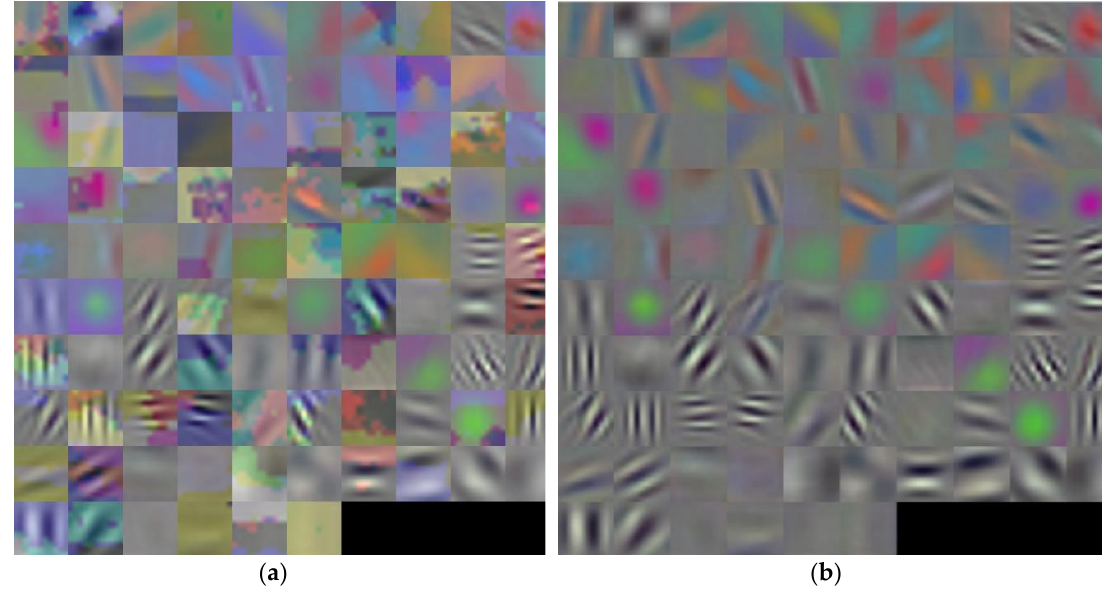
Figure 22. Deep neural networks (DNN) weight visualization for first convolutional layer ( a ) before parameter optimization and ( b ) after training with parameter optimization.